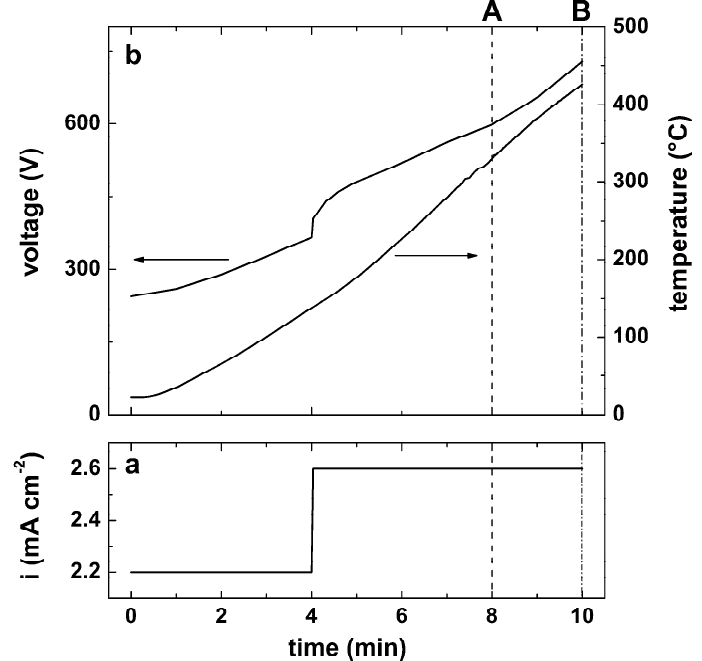
Figure 1. Current density ( a ), voltage drop and bulk temperature ( b ) as a function of time for Type-A and -B glow-discharge treatments. The vertical dashed lines, named A and B, indicate the end of Type-A and -B treatments, respectively. Type-A samples were treated up to 595 ± 5 V (treatment duration: 8 min); Type-B samples were treated up to 730 ± 5 V (treatment duration: 10 min).